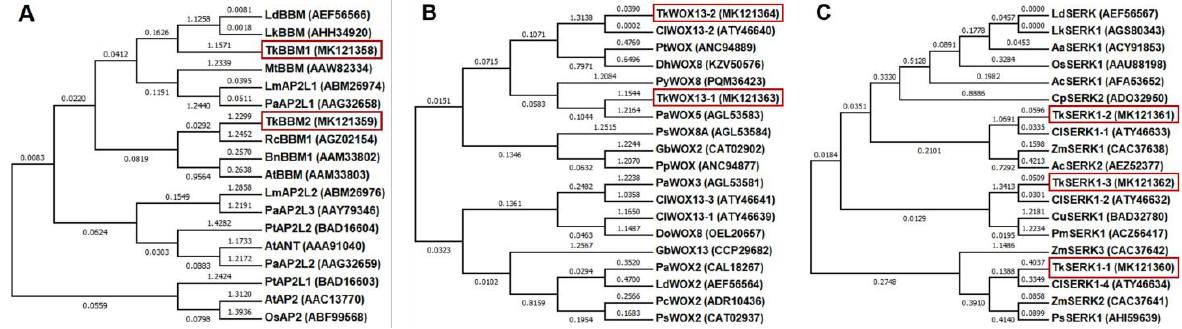
Figure 6. Phylogenetic tree of the putative TkBBM ( TkBBM1 and TkBBM2 ), TkWOX ( TkWOX1 and TkWOX2 ), and TkSERK ( TkSERK1 , TkSERK2, and TkSERK3 ) proteins based on the NCBI database and representatives characterizing each protein from broad plant lineages. ( A ) TkBBM1 and TkBBM2 ; ( B ) TkWOX1 and TkWOX2 ; ( C ) TkSERK1 , TkSERK2, and TkSERK3